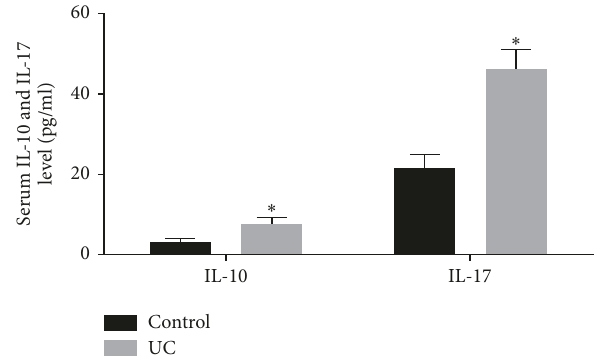
Figure4:SerumlevelsofIL-10andIL-17inulcerativecolitispatients andhealthysubjectsweredetectedwithELISA.IL-10andIL-17levels were significantly higher, compared with control group, ∗ 𝑃 < 0.05